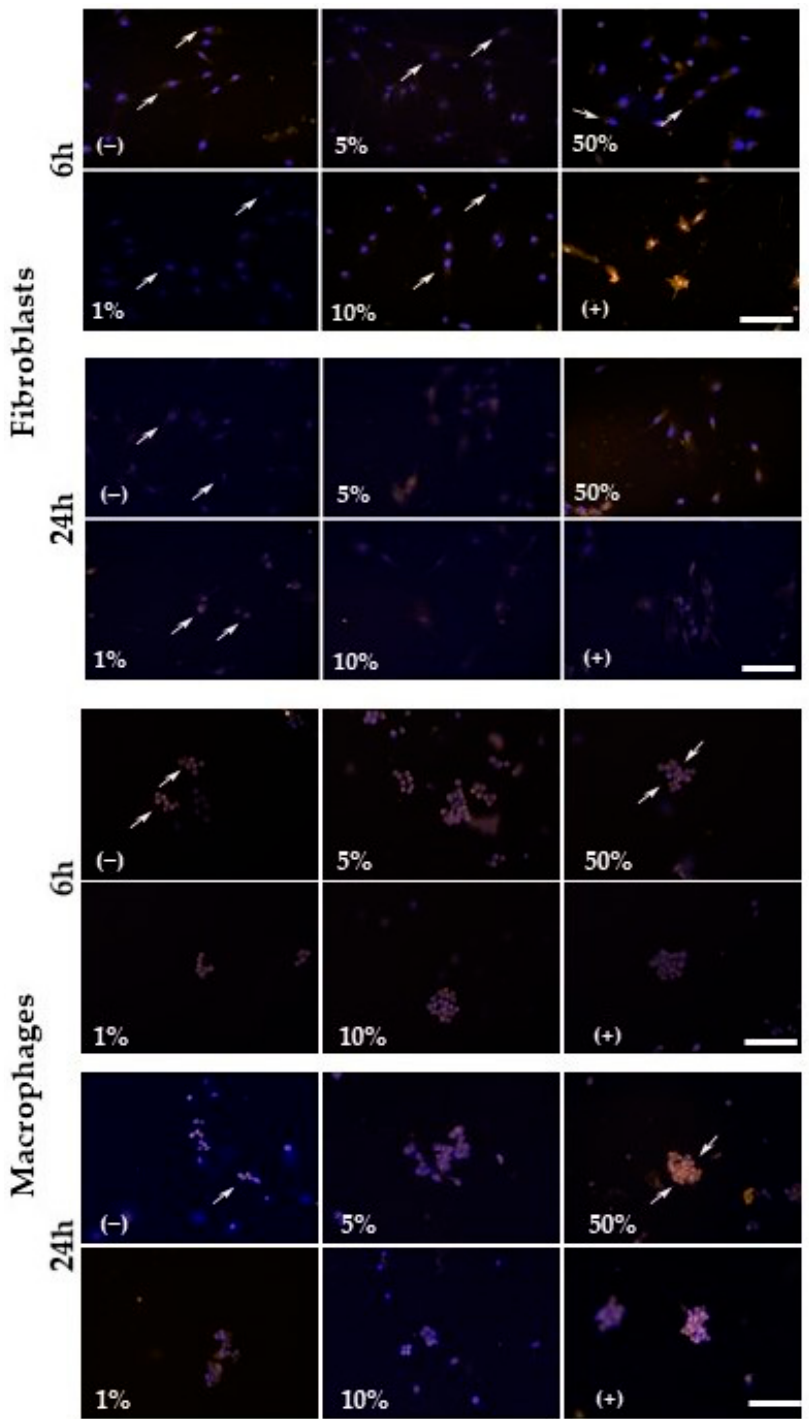
Figure 3. Fluorescence photomicrographs from fibroblast and macrophage cultures. • O 2 − activity was evidenced by MitoSOX Red staining at 6 h and 24 h. Untreated cultures, cultures treated with different concentrations of CFEAS (1%, 5%, 10%, and 50%), and cultures treated with 500 µM H 2 O 2 (positive control of oxidation). Arrows indicate • O 2 − activity (orange), cell nuclei in blue. Bar = 50 µm.